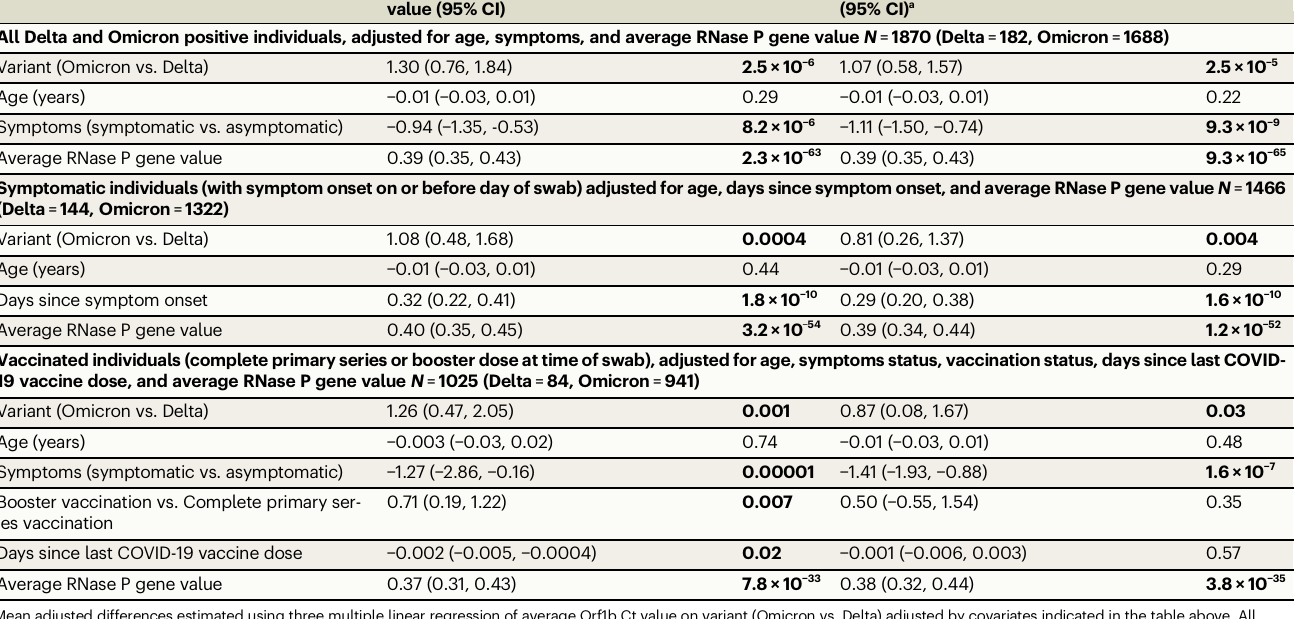
Table 2 | Cycle threshold comparisons by Delta and Omicron variants p -value b Mean adjusteddifferenceinOrf1b Ctvalue p -value b Mean unadjusted difference in Orf1b Ct value (95% CI) (95% CI) a All Delta and Omicron positive individuals, adjusted for age, symptoms, and average RNase P gene value N = 1870 (Delta = 182, Omicron = 1688) Variant (Omicron vs.